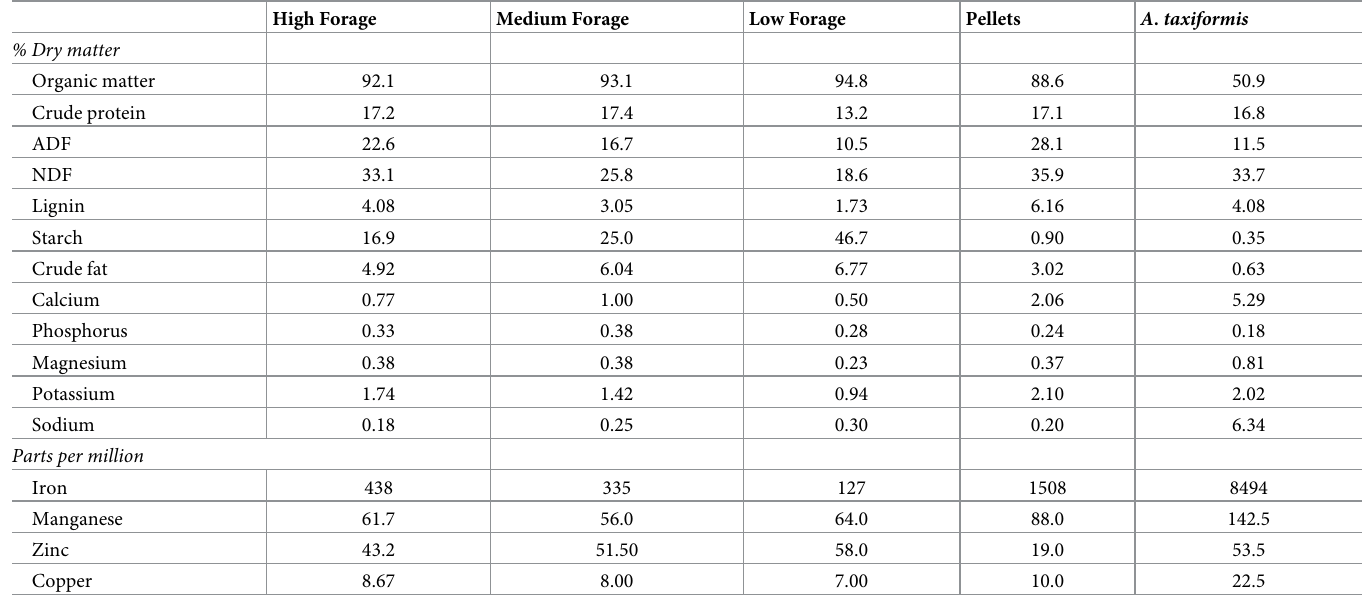
Table 2. Nutritional composition of experimental diets, Asparagopsis taxiformis , and alfalfa